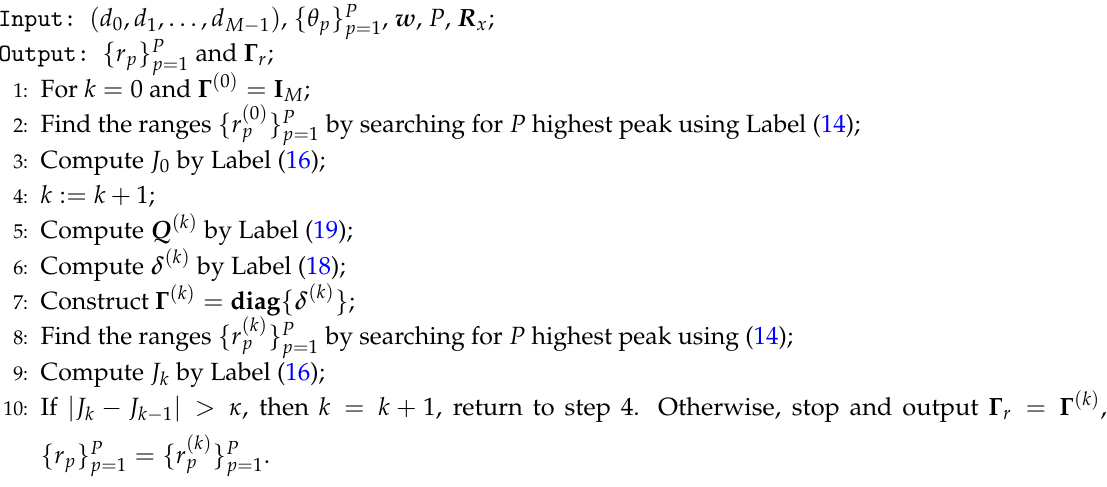
Algorithm 2 Algorithm for the joint estimations of Γ r and r p